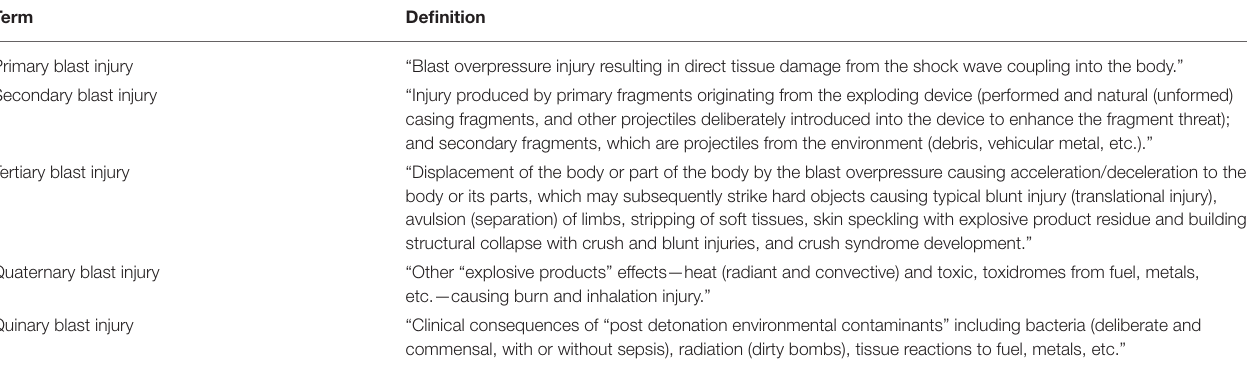
TABLE 3 | Blast-induced injury terminology and definitions as provided in Department of Defense Directive “Medical Research for Prevention, Mitigation, and Treatment of Blast Injuries” (DoDD 6025.21E, July 5,